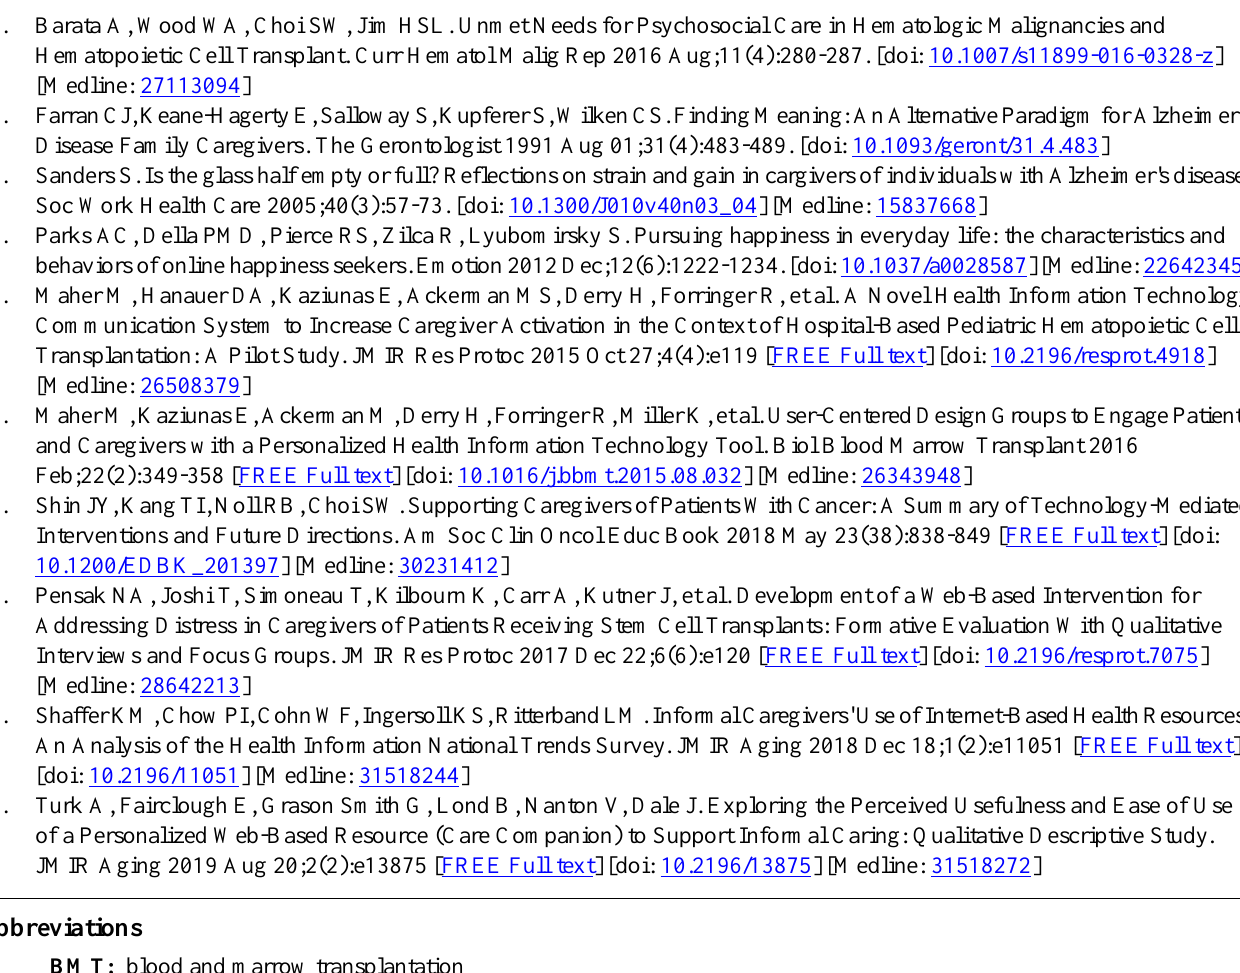
BMT: blood and marrow transplantation HCT: hematopoietic stem cell